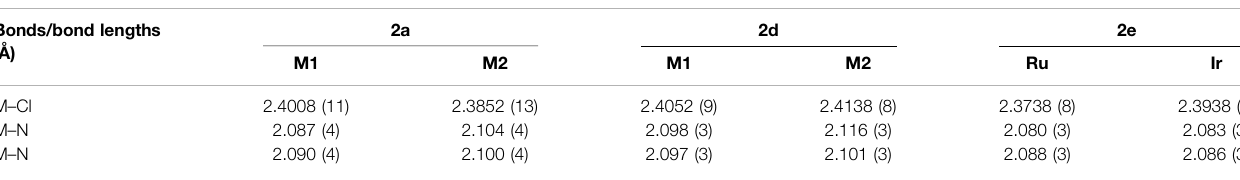
TABLE 1 | Key bond lengths (Å) in the molecular structures of 2a , 2d and 2e . Bonds/bond lengths (Å)